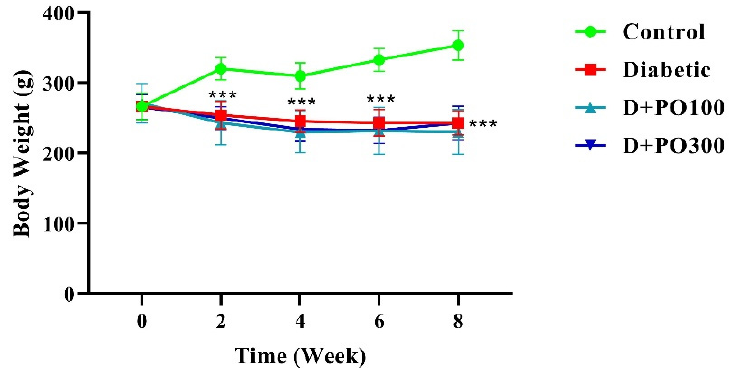
Figure 4. The effects of PO extract on body weight in diabetic rats. The data are presented as mean ± SD. A repeated-measures two-way ANOVA test was carried out with the following Tukey–Kramer’s post hoc test; *** p < 0.001 vs. control group.